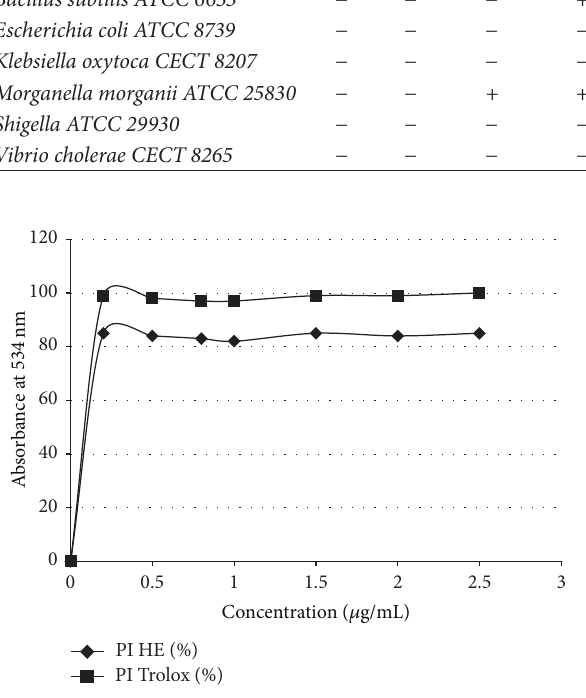
Figure 3: Scavenging of DPPH radical from cones essential oil of Cupressus sempervirens .